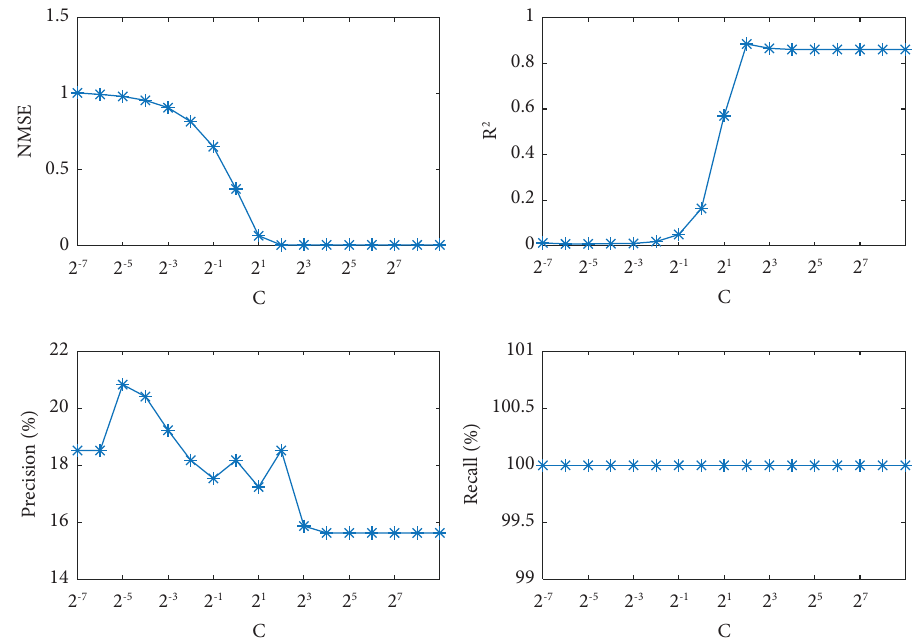
Figure 6: Te infuence of C on the NMSE, R 2 , precision, and recall for the Type C dataset. Parameter p is fxed as the optimal value. Table 3: Comparison results of FS-NSVR, L 1 -SVR, L p -SVR, and L 1 -LSSVR for artifcial datasets. Data sets